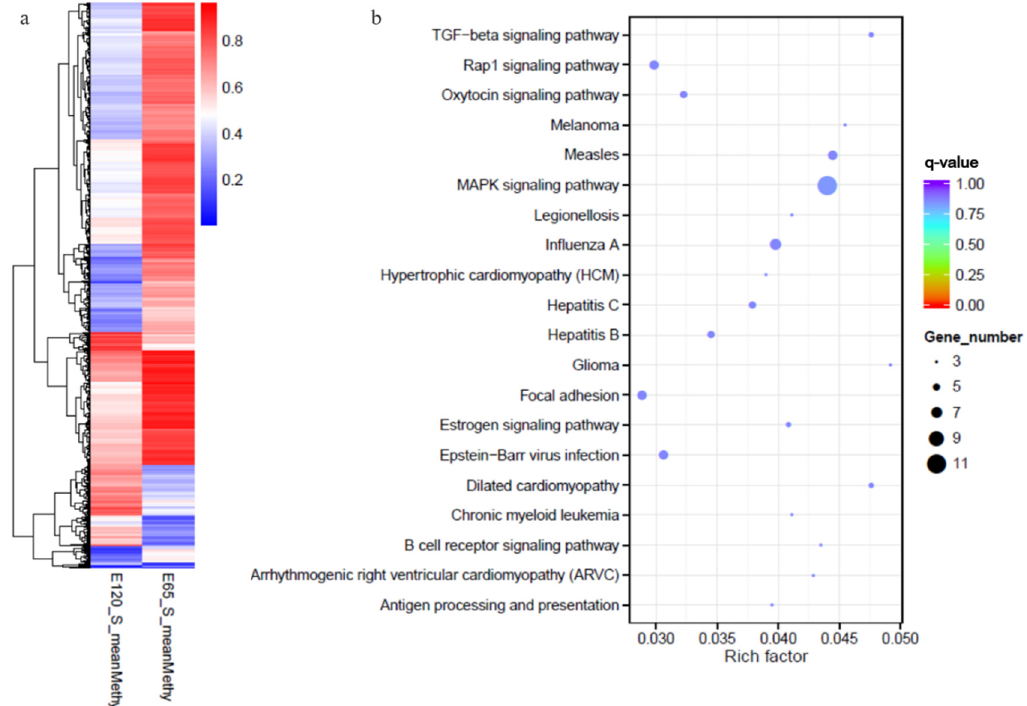
Figure 9. The heat map and Kyoto Encyclopedia of Genes and Genomes (KEGG) analysis of genes with di ff erential methylation between E 65 and E 120. ( a ) The heat map of the genes with di ff erential methylation between E 65 and E 120. ( b ) The KEGG analysis of the genes with di ff erential methylation between E 65 and E 120. In total, 3371 di ff erentially methylated genes (DMGs) were identified between the two stages. KEGG analysis revealed that the DMGs were enriched in TGF- β and focal adhesion signaling pathways.